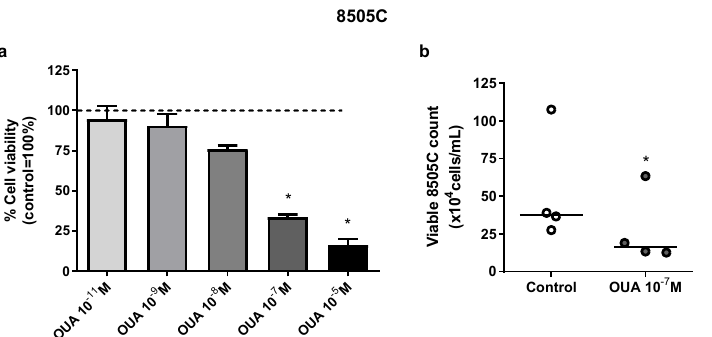
Figure 1. Ouabain decreased 8505C viability in vitro. 8505C cells were cultured in the absence or presence of ouabain at concentrations that ranged from 10 − 5 – 10 − 11 M for 24 h. Next, cell viability was evaluated with MTT assay or using cell counting in a Neubauer chamber using trypan blue. ( a ) MTT absorbance values of ouabain-treated cultures were normalized to their respective control and data are presented as the mean relative percentage of viable 8505C cells ± SEM after 24 h of culture. ( b ) Scatter plots represent the absolute number of viable 8505C cells with reference lines showing the medians. At least three independent experiments were performed for each condition. * p < 0.05 using repeated measures ANOVA with Dunnett´s post-test and paired t-test, respectively.